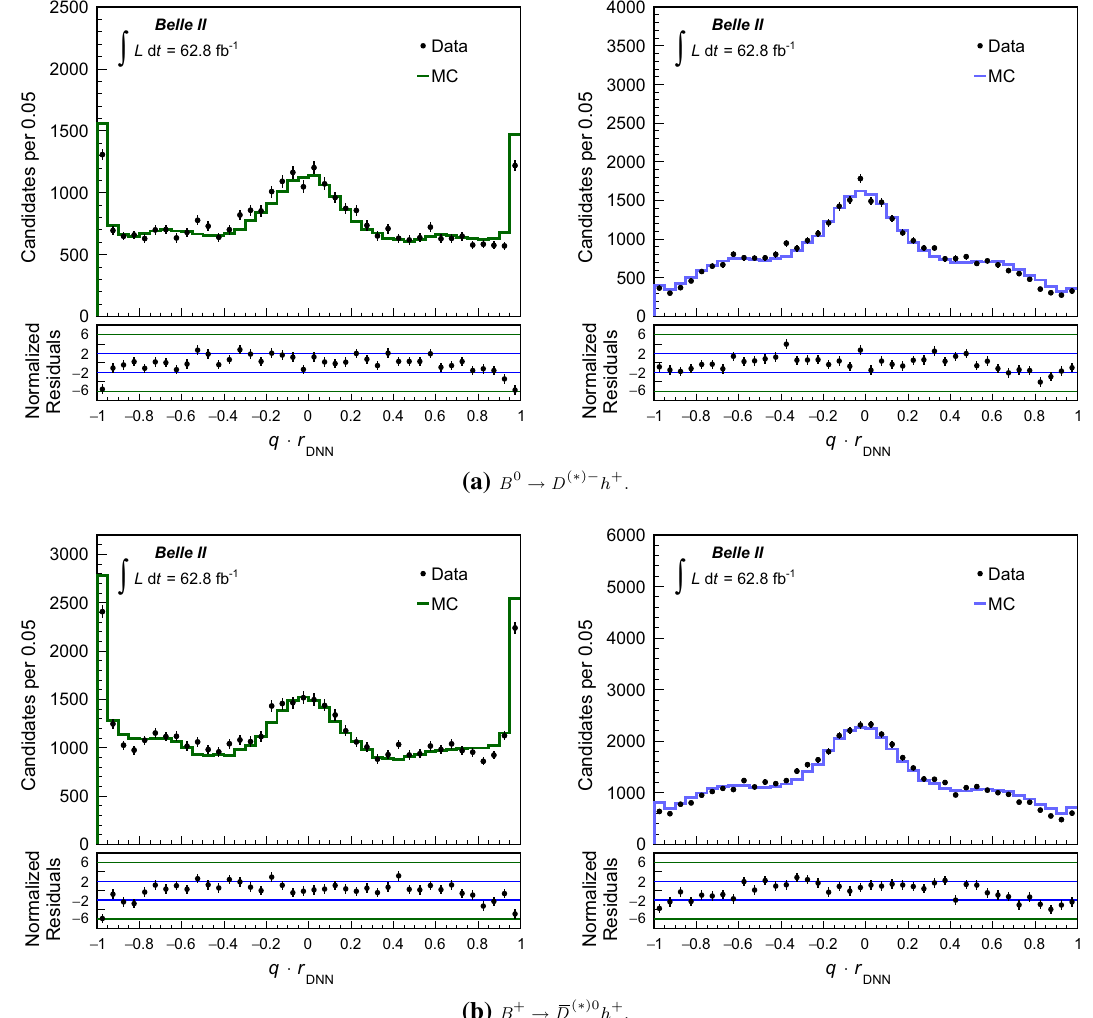
Fig. 8 Normalized q · r distributions obtained with the DNN tagger in data and MC simulation. The contribution (left) from the signal compo- nent in data is compared with correctly associated signal MC events and